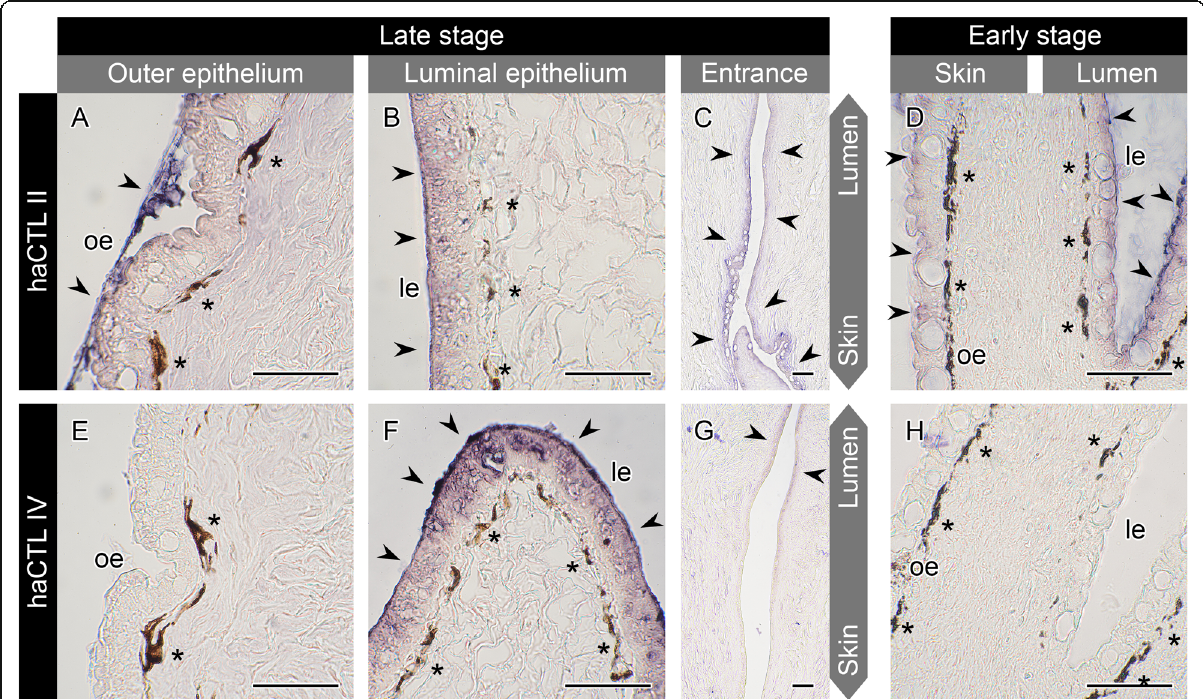
Fig. 9 Immunohistochemical analysis of seahorse brood pouch with anti-haCTL II and anti-haCTL IV antibodies. Sections of late-stage brood pouch were immunostained with anti-haCTL II ( a – c ) and anti-haCTL IV ( e – g ) antibodies: outer epithelium ( a , e ), luminal epithelium ( b , f ), and pouch entrance ( c , g ). Sections of early-stage brood pouch were immunostained with anti-haCTL II ( d ) and anti-haCTL IV ( h ) antibodies. Arrowheads indicate positive signals, and asterisks indicate pigment cells. le, luminal epithelium; oe, outer epithelium. Scale bars = 50 μ m. Sections for a – c and e – g were derived from one individual, and those of d and h were derived from another